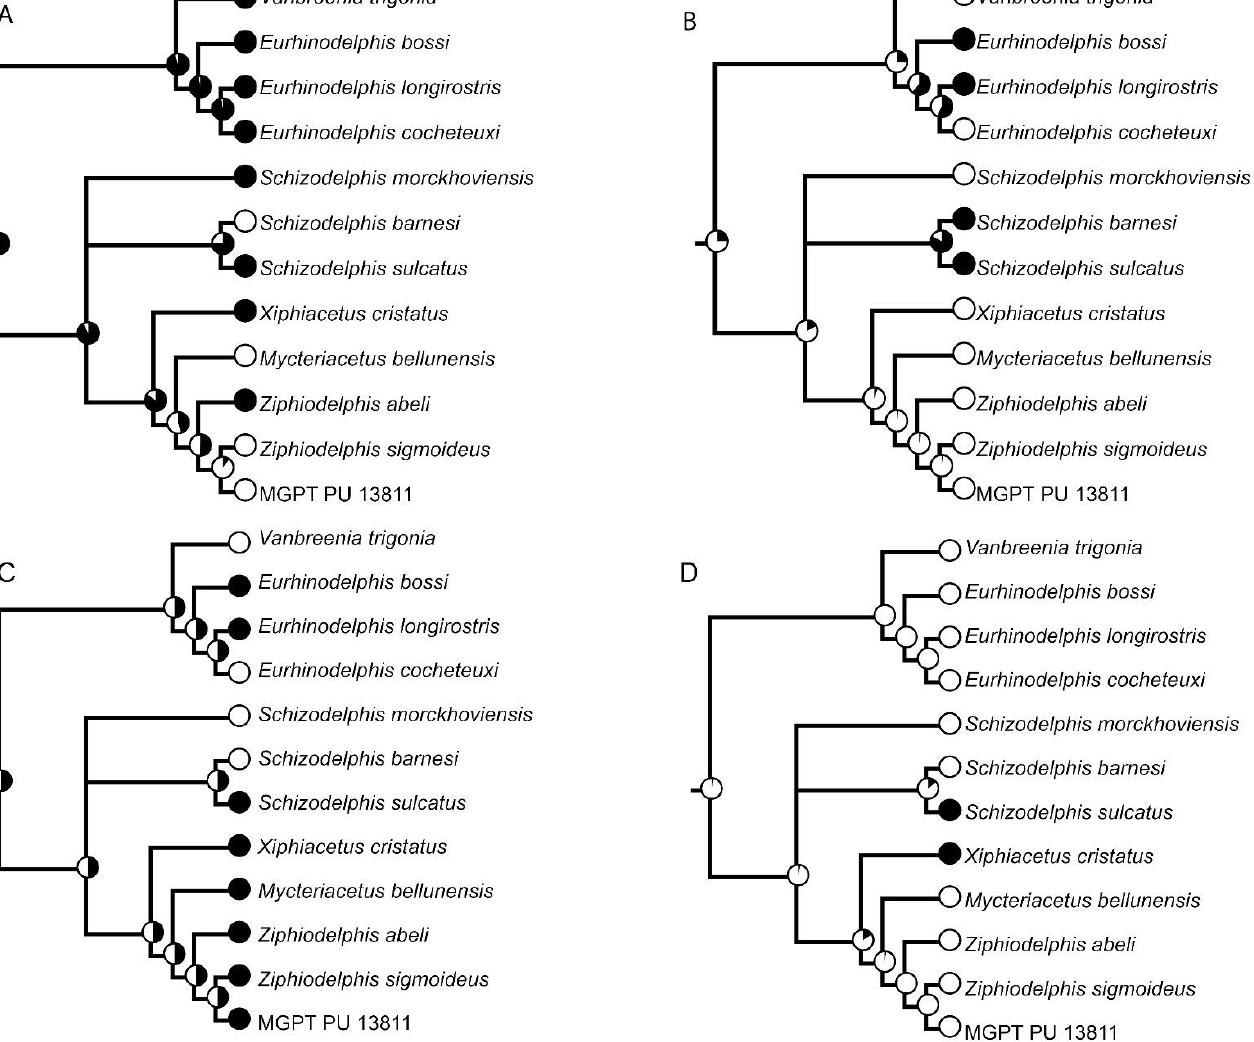
Figure 20. Paleobiogeographic relationships of Eurhinodelphinidae with reconstructions of ancestral geographic states at nodes. ( A ) Northeast Atlantic distributions. ( B ) Northeast Atlantic distributions. ( C ) Mediterranean distributions. ( D ) Paratethys distributions. Pie charts at internal nodes show ML probabilities of ancestral distributions.